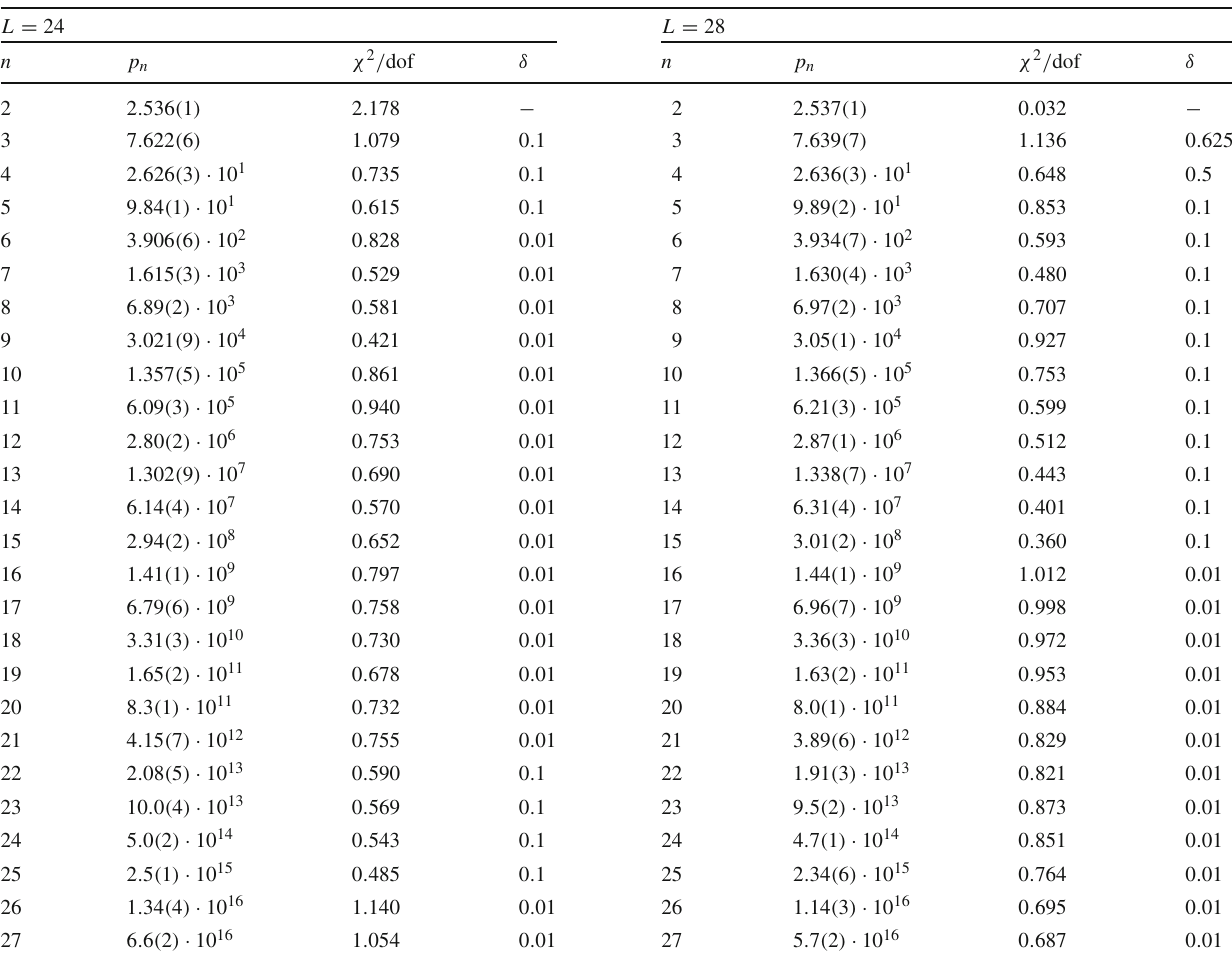
Fig. 8 In the left panel, correlation matrix between the coefficients p 2 ,..., p 35 at L = 48 extracted from the combined fit procedure. The entrances can be bigger than 1 because the matrix is not positive definite. In the right panel, the nearest correlation matrix obtained with Higham’s algorithm ( δ = 10 − 10 ) Table 3 Plaquette coefficients from the combined fit for L = 24, 28, 32, 48. The tolerance δ is given only when the covariance matrix is found not to be positive